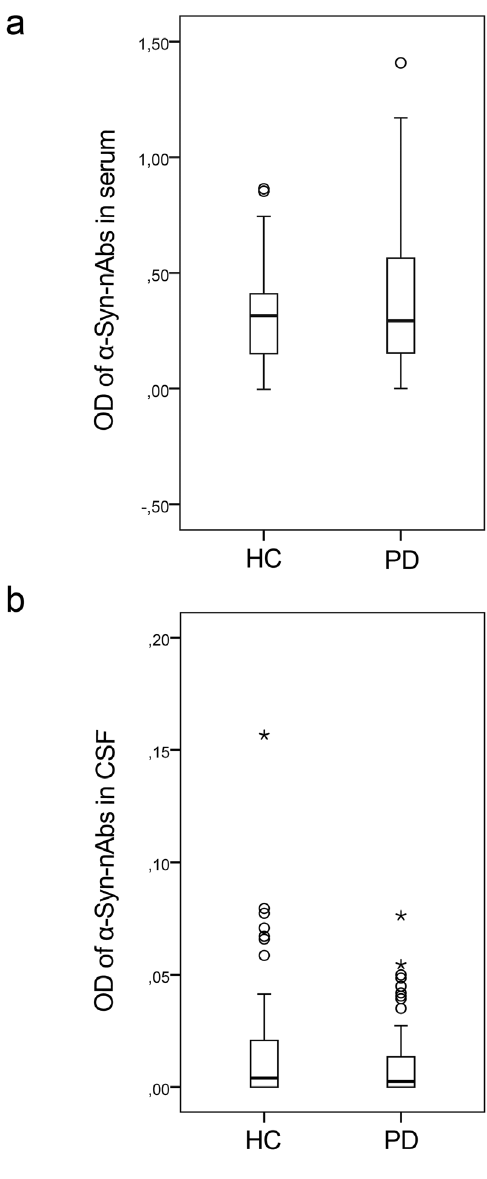
Figure 1. Results of the ELISA of a -Syn-nAbs quantified by optical density (OD) in a) serum and b) cerebrospinal fluid (CSF) of healthy controls (HC) and Parkinson’s disease (PD)